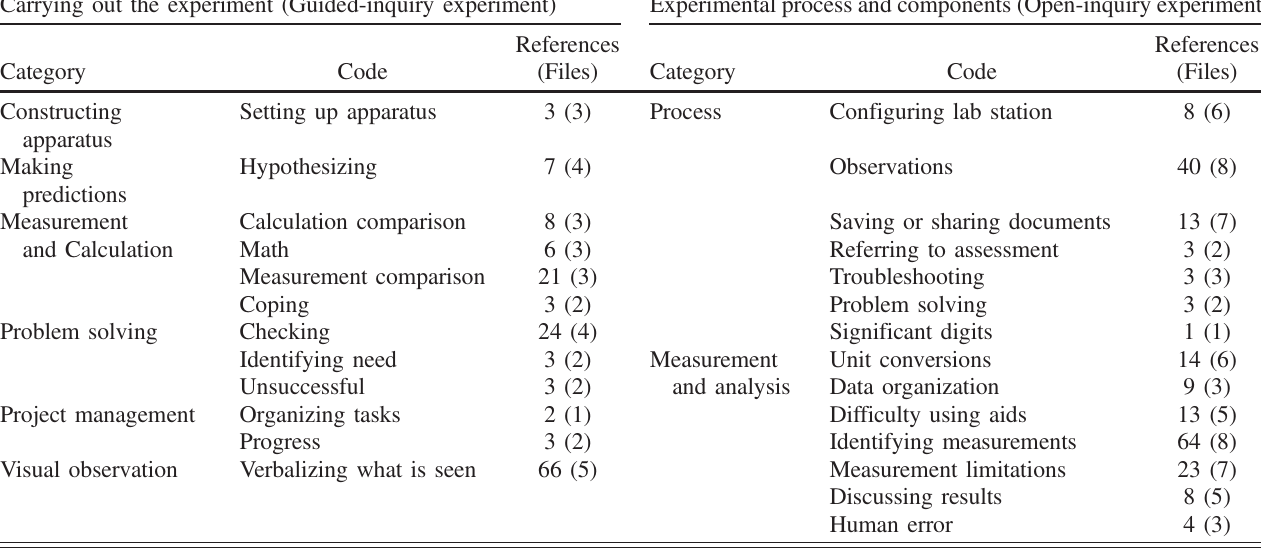
TABLE VI. Open codes that are unique in the carrying out the experiment theme in the guided-inquiry data set in comparison to the experimental process and components theme in the open-inquiry data set. The numbers shown in the table are how many times each code is referenced in the corresponding experiment and how many files each code is referenced (shown in parentheses). Note that there are a total of 5 guided-inquiry files and 8 open-inquiry